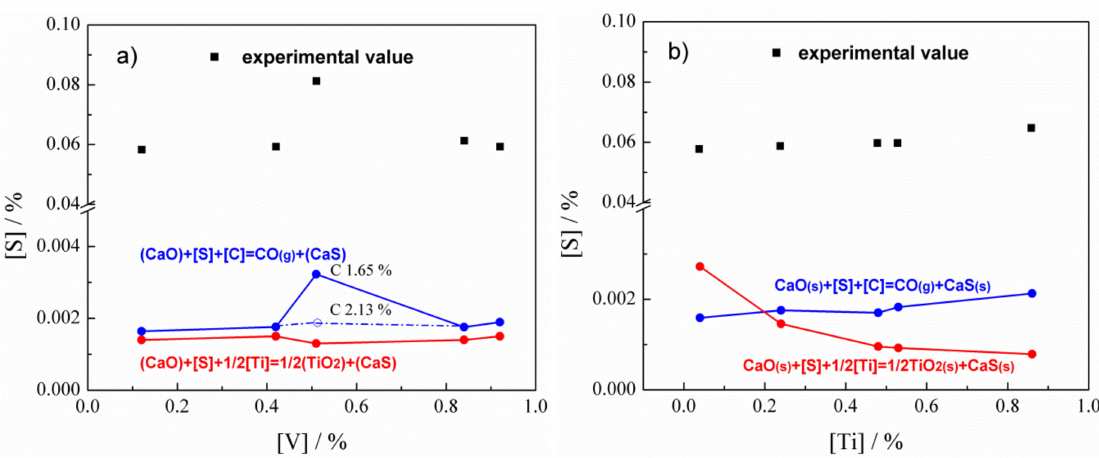
Figure 9. Sulfur content with the change of ( a ) vanadium and ( b )